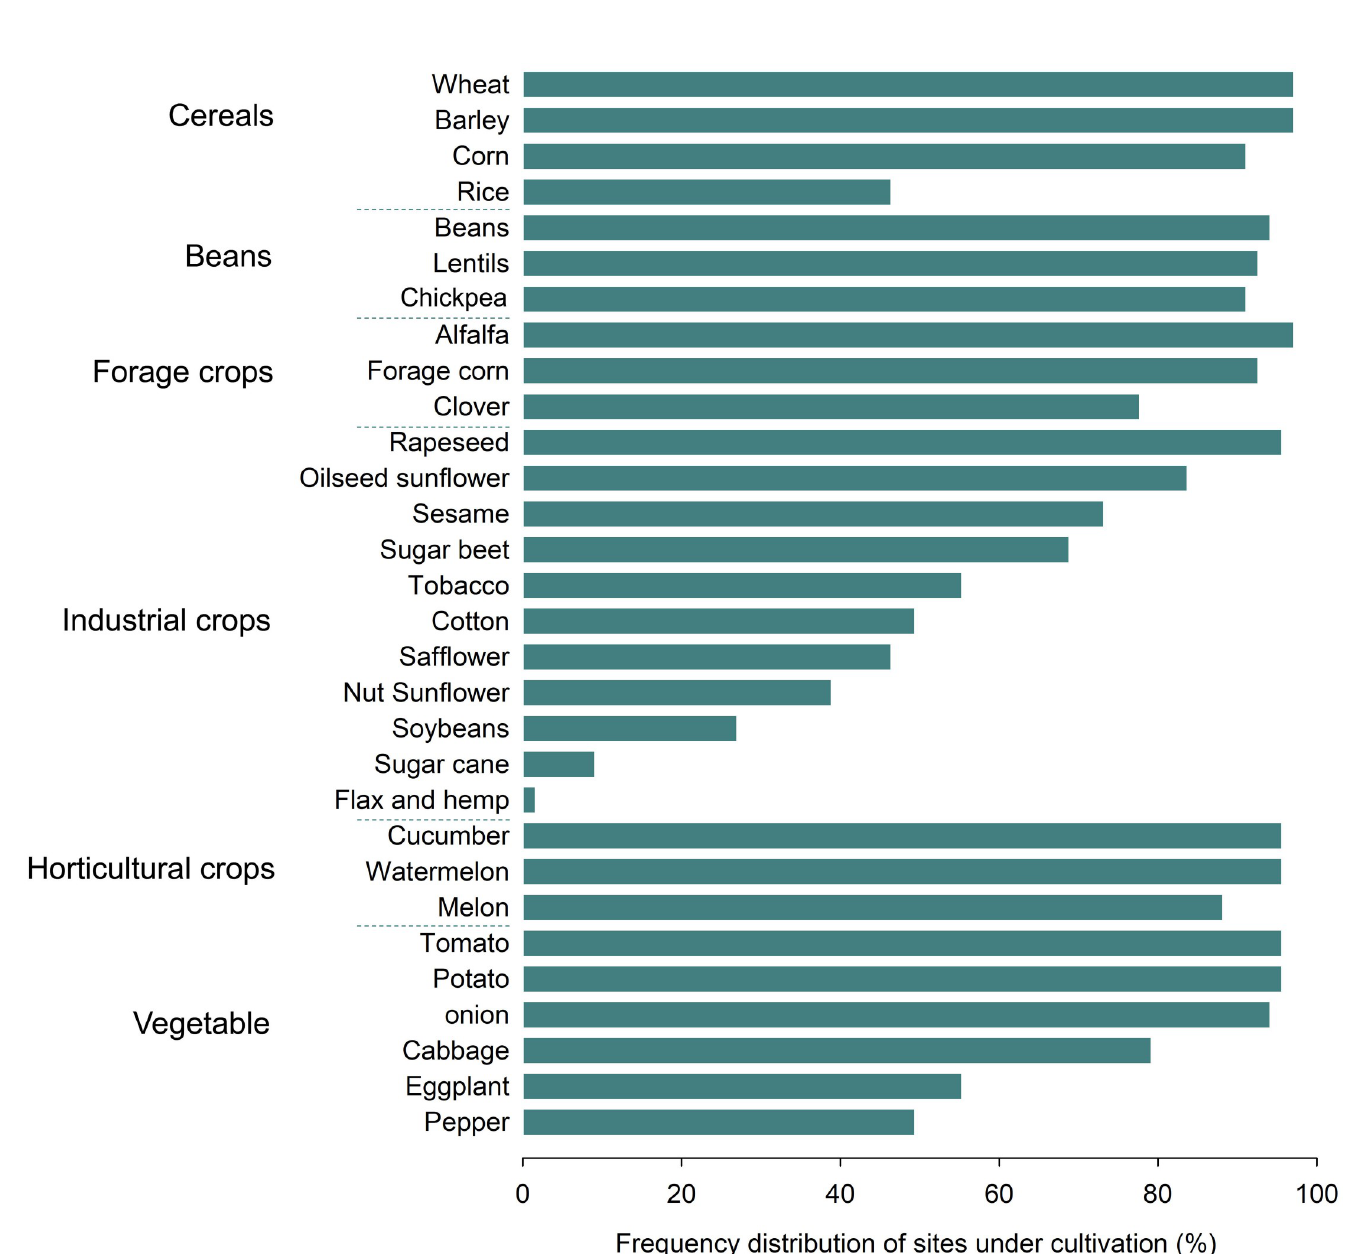
Fig 9. List of crops and the frequency distribution of sites under their cultivation in Iran. Created using ggplot2 R-package.